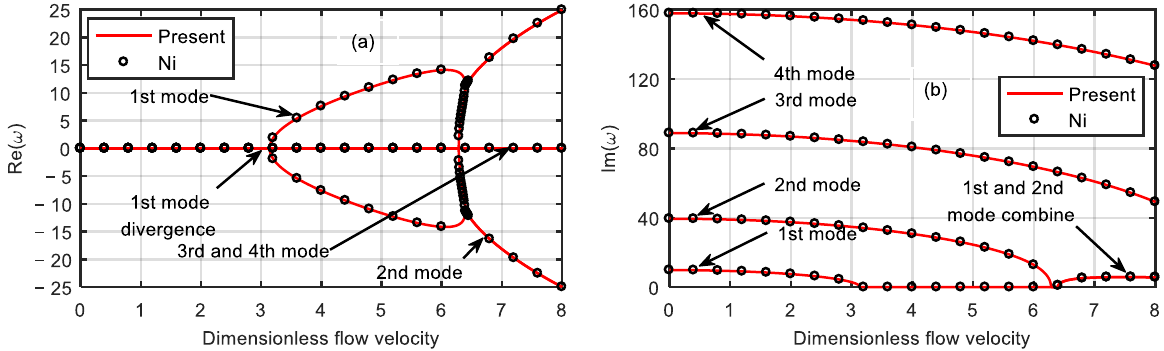
Figure 2. Variations of first four order eigenfrequencies with the dimensionless flow velocity. ( a ) Real part. ( b ) Imaginary part.